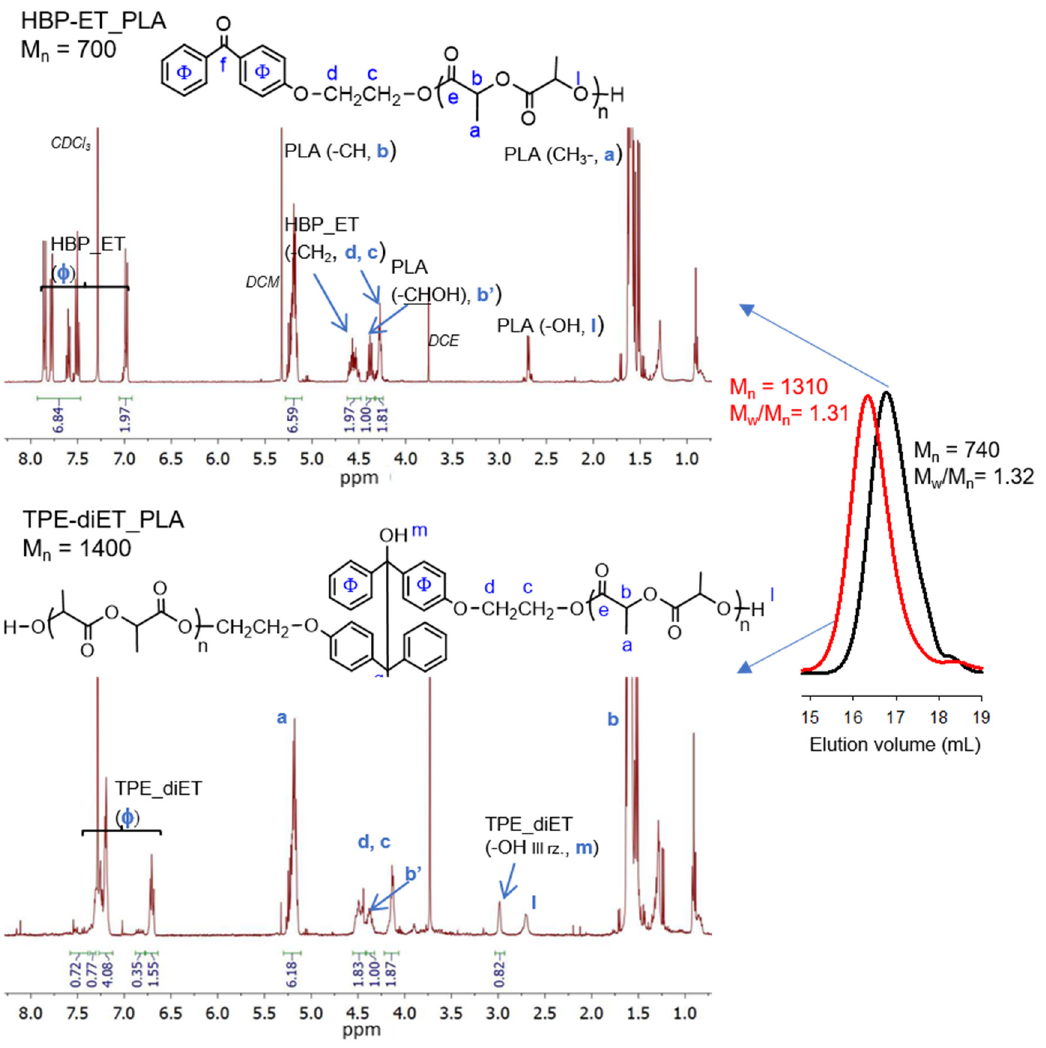
Figure 3. 1 H NMR spectra (CDCl 3 ) and SEC curves (DCM) of HBP-ET_PLA, M n =700 (top, SEC black line) and TPE-diET_PLA, M n = 1400 (bottom, SEC red line).